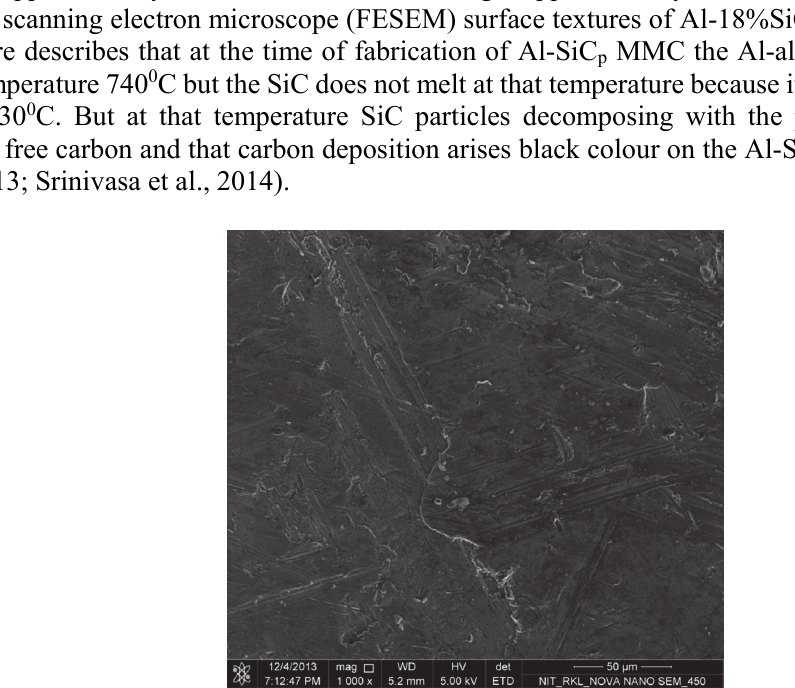
Machining parameter Levels